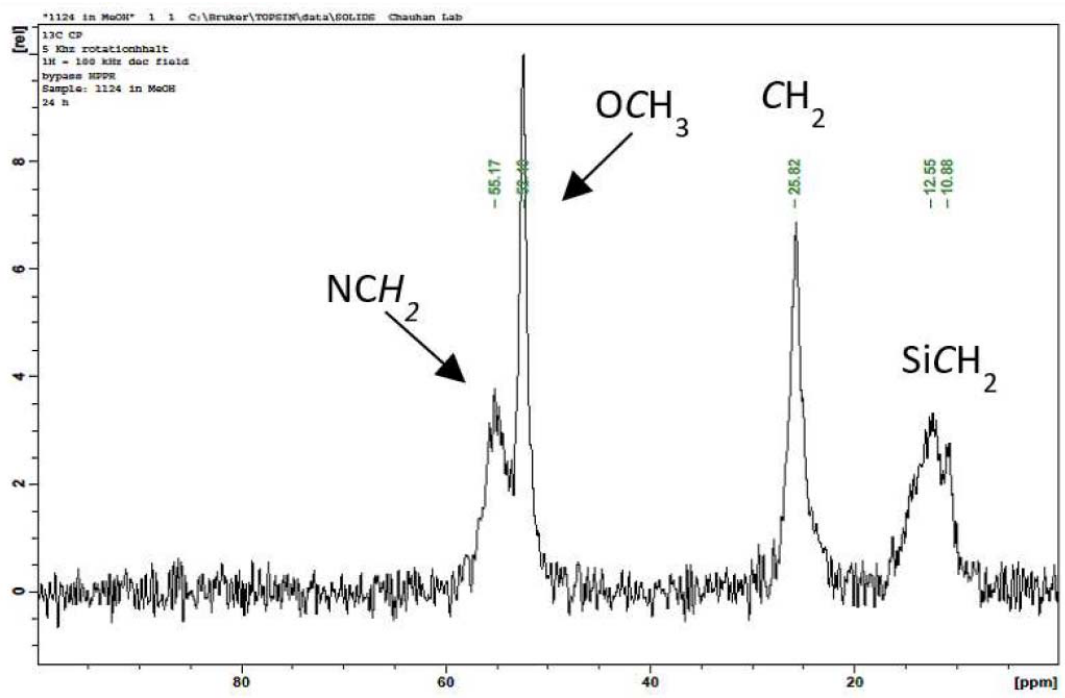
Figure 1. Solid state 13 C ‐ NMR of the amino ‐ bridged gel P1 .